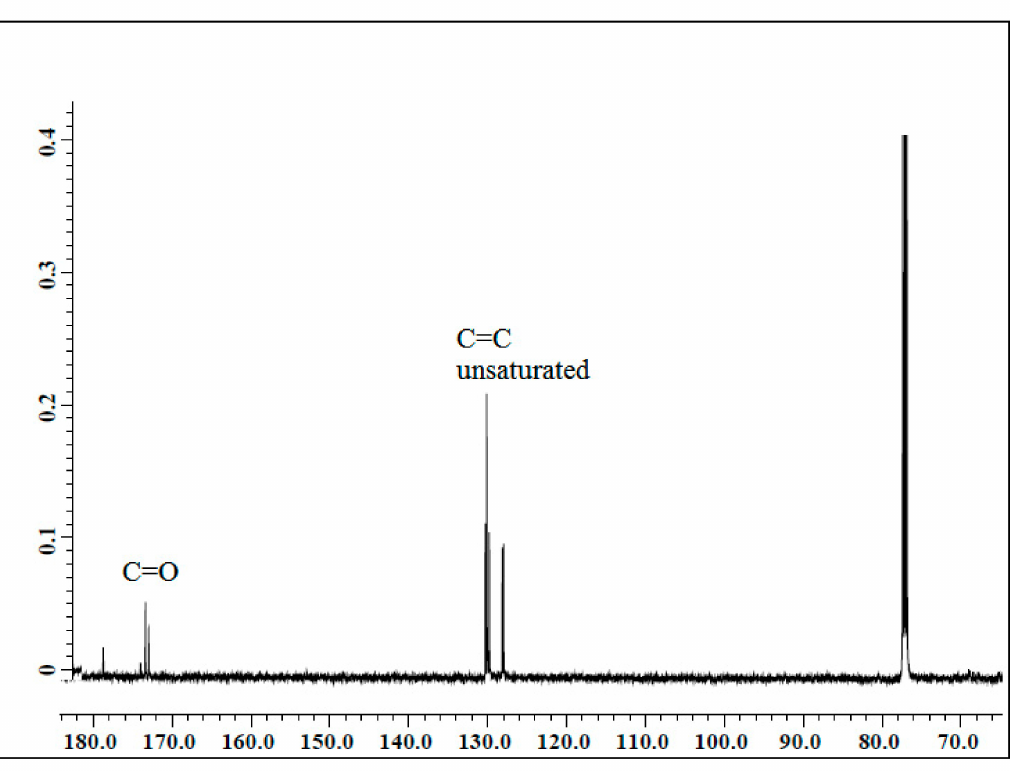
Figure 1. 13 C NMR spectrum of jatropha oil.